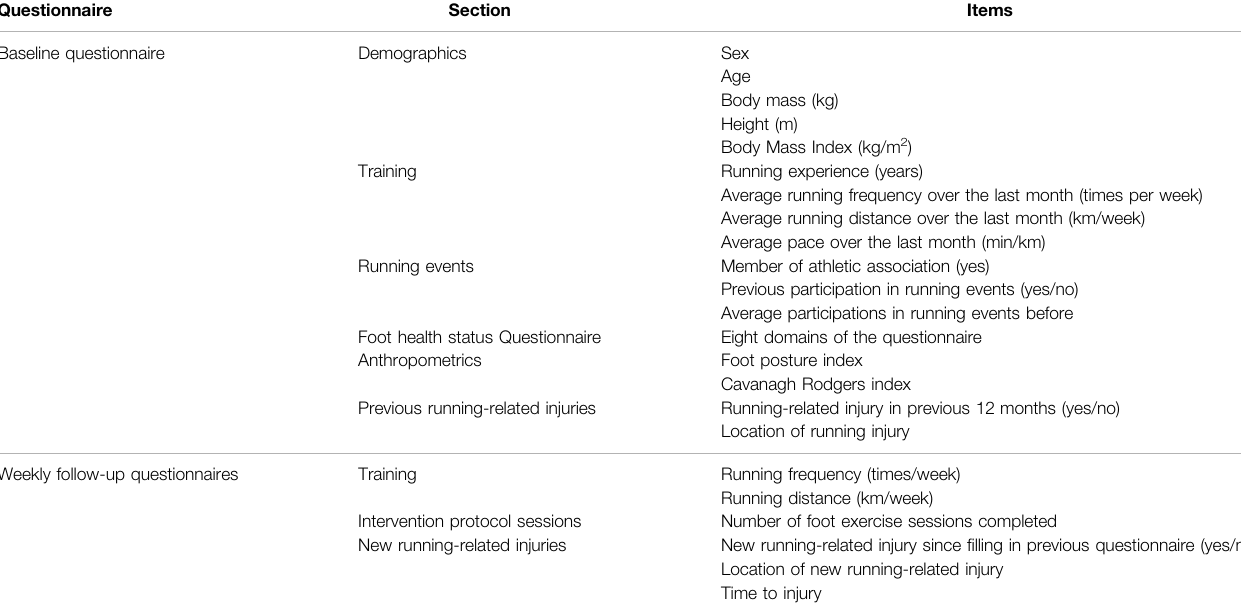
TABLE 1 | Baseline questionnaire and